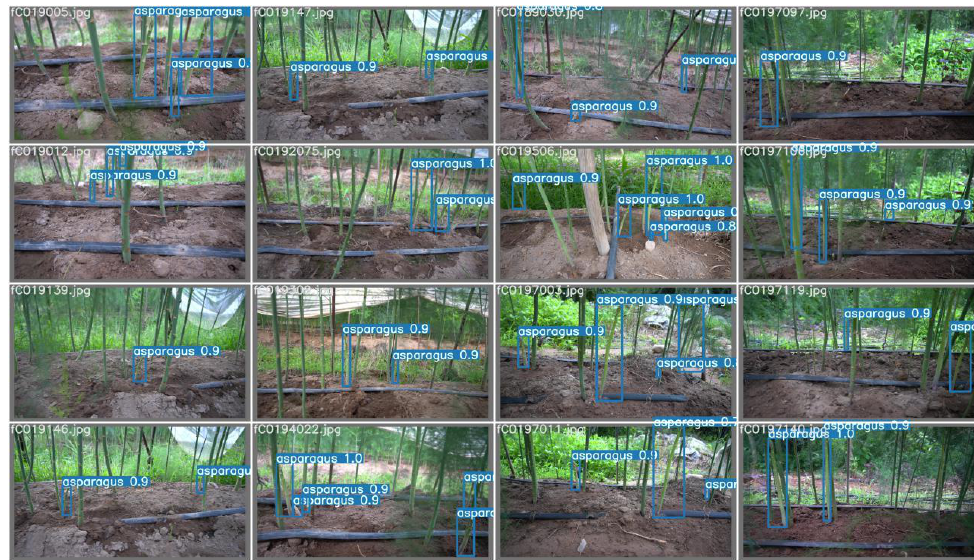
Figure 12. Batch detection effect.